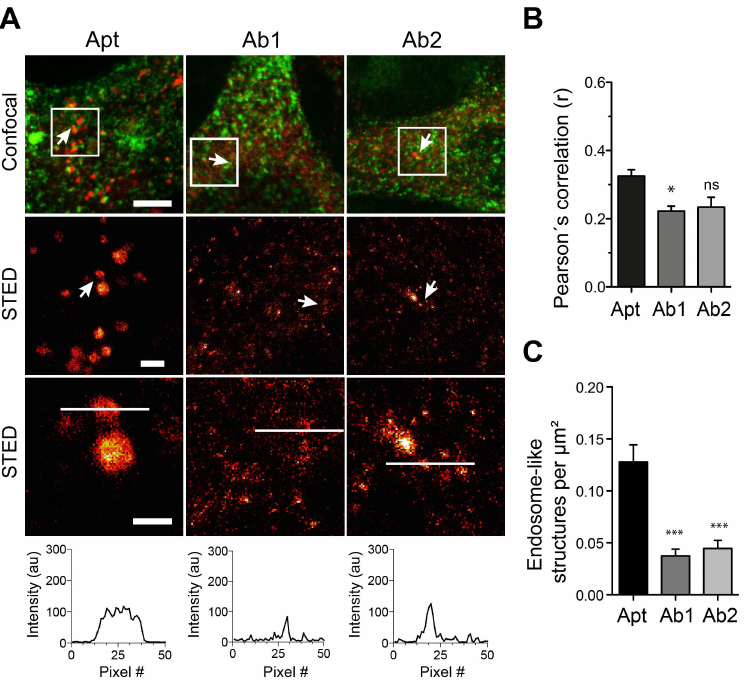
Fig 8. Recognition of subcellular structuresusing STED microscopy in aptameror antibody stained samples against Epha2. Figure legendis equivalentto legendon Fig 6, but for